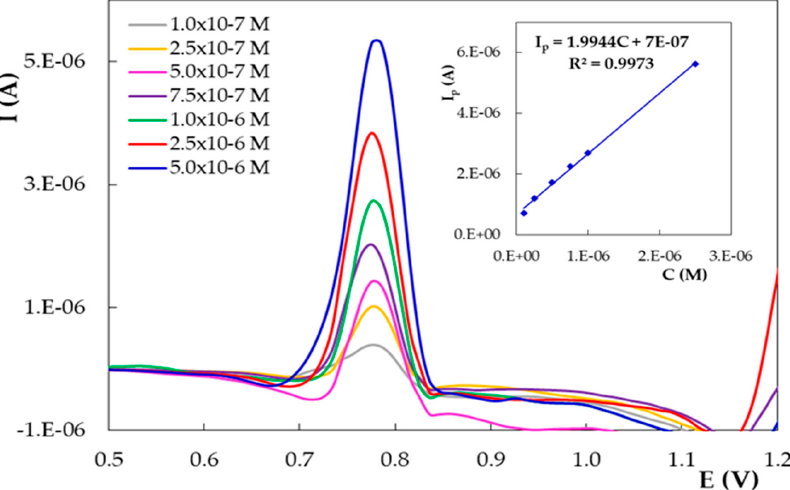
Figure 12. Adsorptive stripping differential pulse voltammograms recorded on PGE_H for different concentrations of DIO in 0.10 mol/L H 2 SO 4 ; E acc = 0.000 V and t acc = 60 s. The inset shows the corresponding calibration curve.